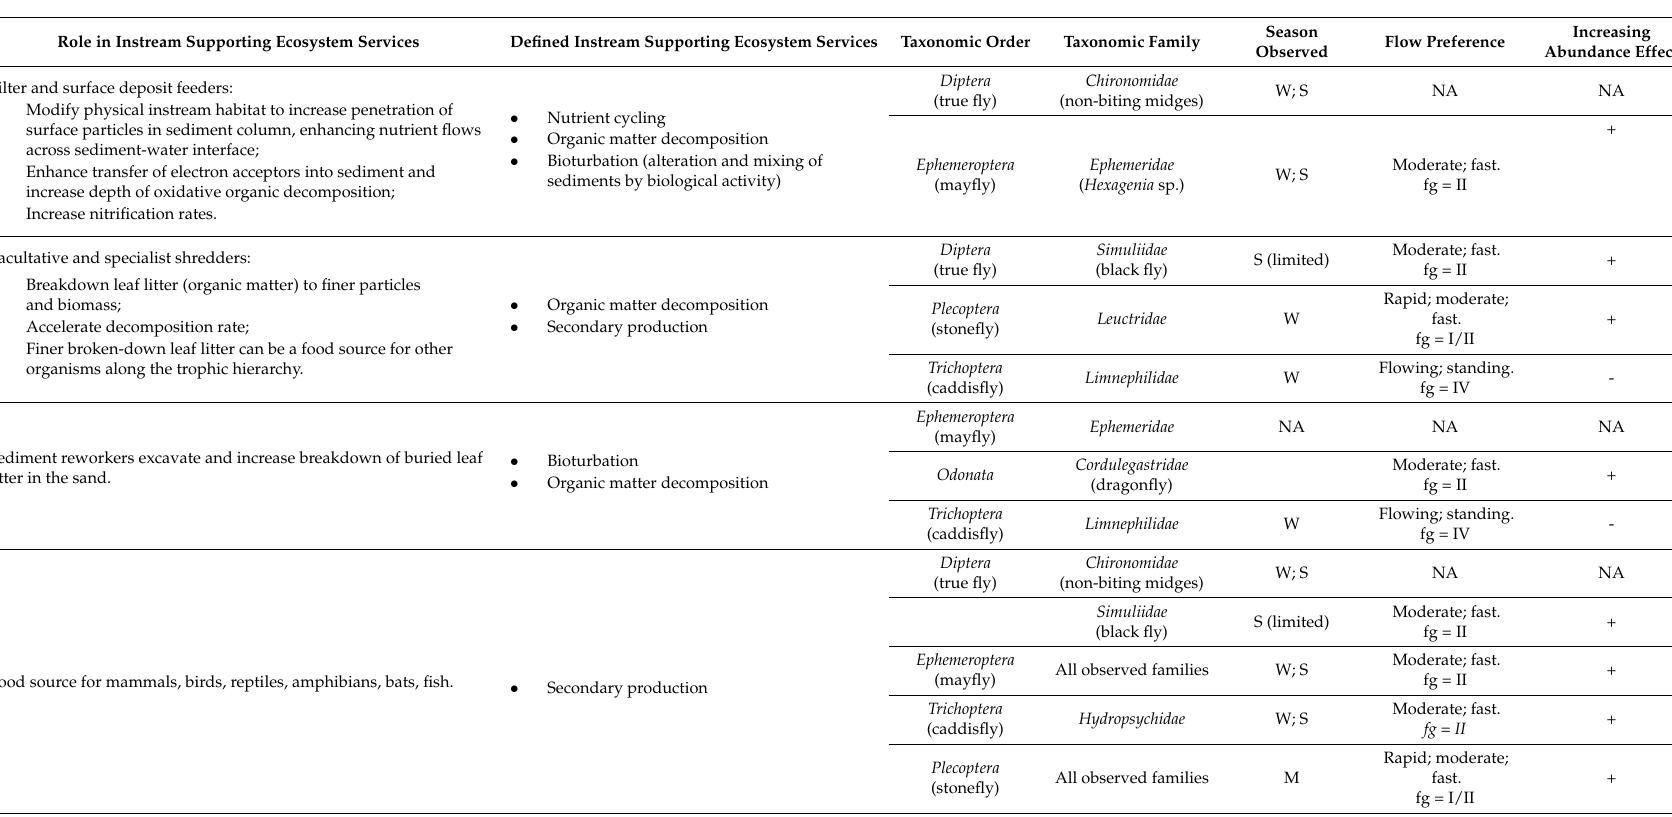
Table 3. Beas River catalogue of instream ecosystem services and the effect increasing abundance of given families has on LIFE score. Latin and common names are indicated in italics and brackets respectively; fg stands for flow group following [21]. The seasons in which taxa are observed in is indicated by W (winter), S (summer), and M